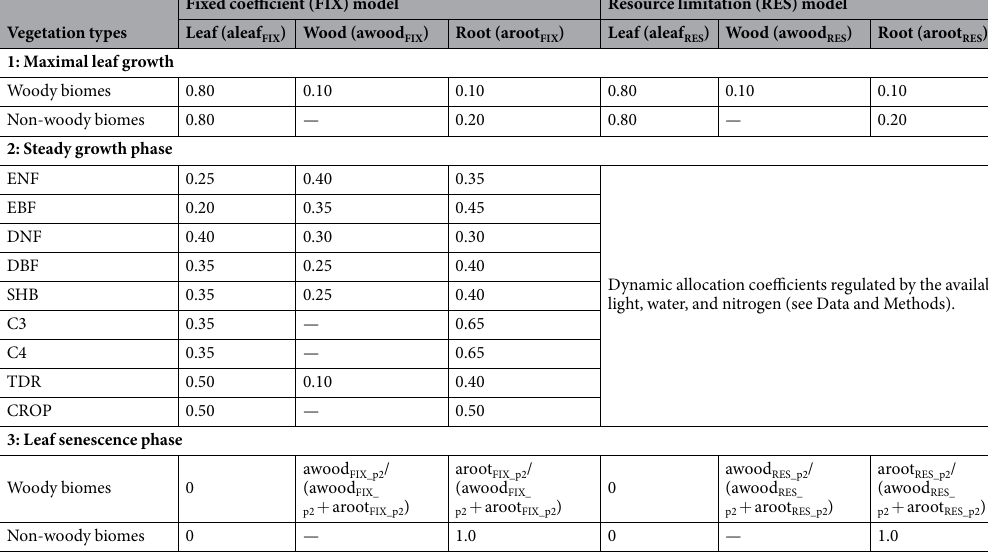
Table 1. Carbon allocation parameters in two carbon allocation schemes in CABLE. ENF: evergreen needleleaf forest; EBF: evergreen broadleaf forest; DNF: deciduous needleleaf forest; DBF: deciduous broadleaf forest; SHB: shrub; C3: C3 grass; C4: C4 grass; TDR: tundra; CROP: C3 crop. ENF, EBF, DNF, DBF, SHB, and TDR are woody biomes. C3, C4, and CROP are non-woody biomes. awood FIX_p2 and aroot FIX_p2 denote the fixed carbon allocation ratios to wood tissues and roots in the steady growth phase (phase 2). awood RES_p2 and aroot RES_p2 denote the resource limitation carbon allocation ratios to wood tissues and roots in the steady growth phase (phase